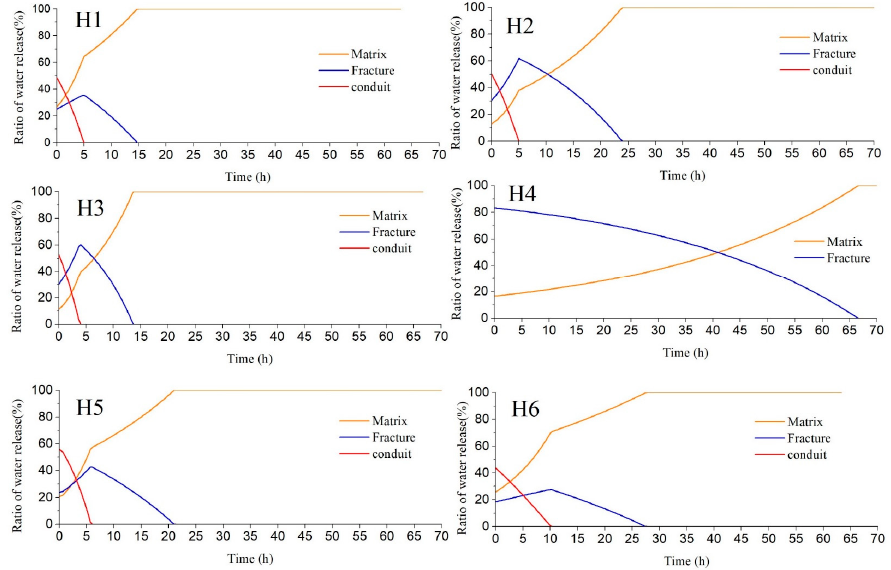
Figure 6. Variation in water release ratio of different media under heavy rain.